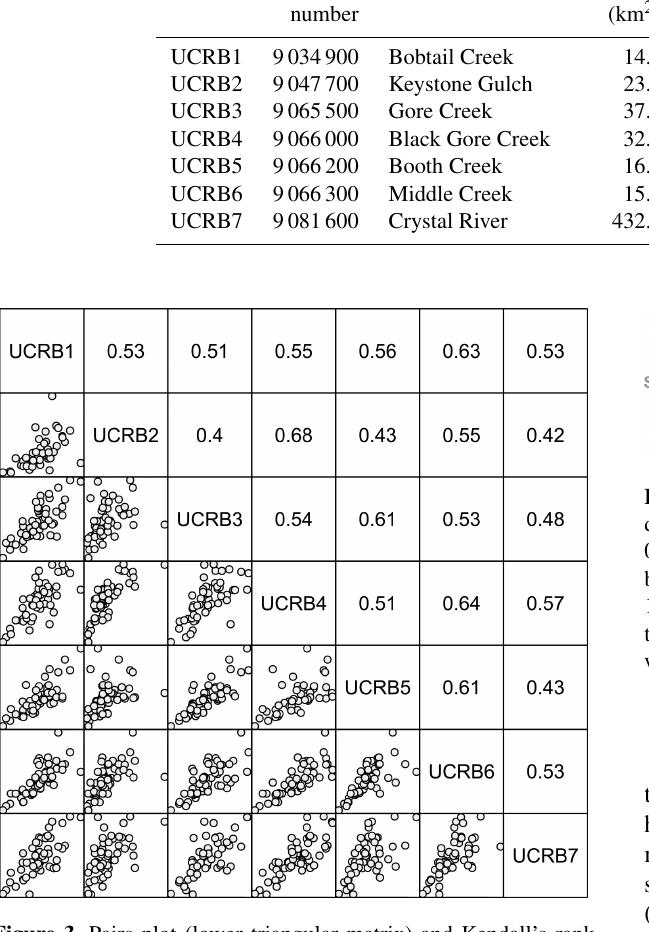
Figure 3. Pairs plot (lower triangular matrix) and Kendall’s rank correlation coefficients (upper triangular matrix) of spring 3d maxi- mum streamflow between the seven stations in the UCRB. Kendall’s rank correlation is significant ( p values < 0.1), and positive associ- ation patterns are visible for all pairs.